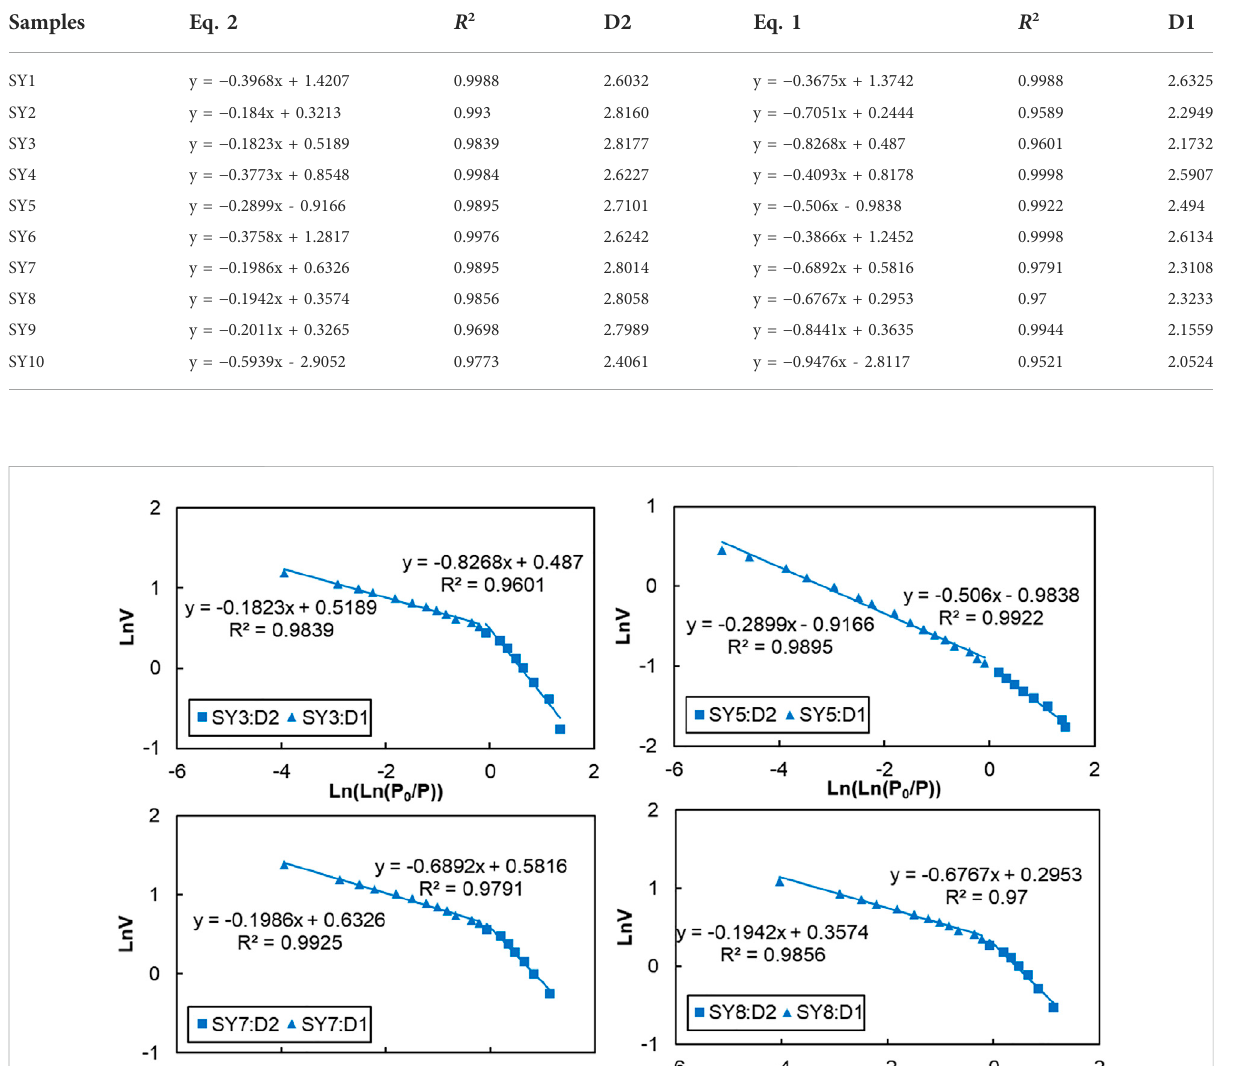
TABLE 3 Fitting equation and fractal dimensions of shale samples.